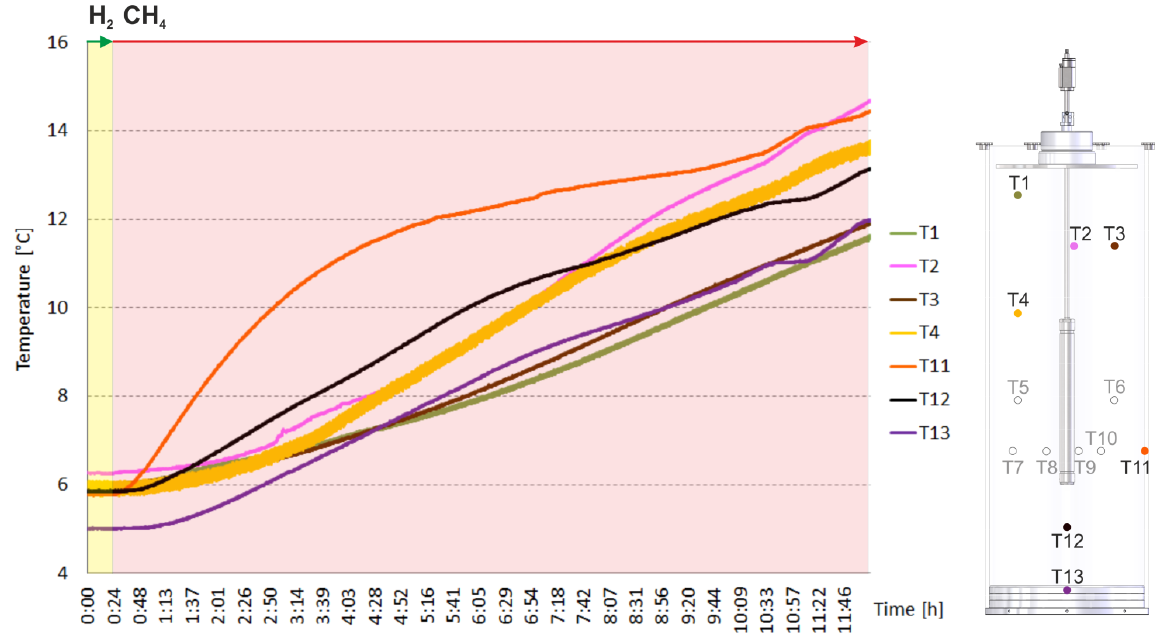
Figure 7. Left: Temperature profiles versus time for heating experiments using the reactor in sediment + water + hydrate (80%) without external cooling. Right: Positions of the temperature sensors within LARS, empty circles show positions of temperature sensors whose profiles are not shown in the